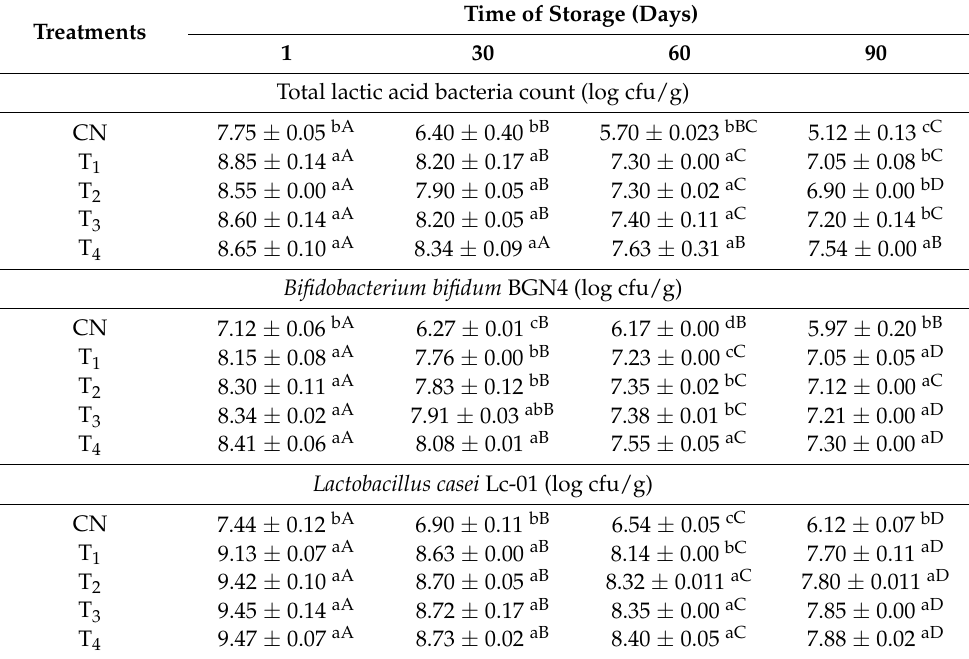
Table 6. Changes in total lactic acid bacteria count, Bifidobacterium bifidum and Lactobacillus casei in frozen yoghurt affected by adding substantial ratios of JATP during cold storage.